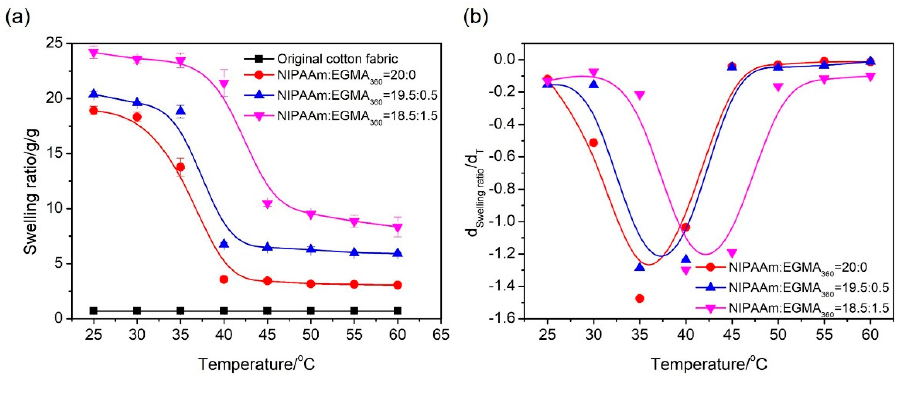
Figure 13. ( a ) Equilibrium swelling ratio of cotton fabric grafted alginate-Ca 2+ /P(NIPAAm- co -EGMA 360 ) hydrogels as a function of temperature in water. ( b ) First derivatives of the equilibrium swelling ratios with respect to the temperature plotted as a function of temperature. The monomer ratios of NIPAAm to EGMA 360 are 20:0, 19.5:0.5, and 18.5:1.5.